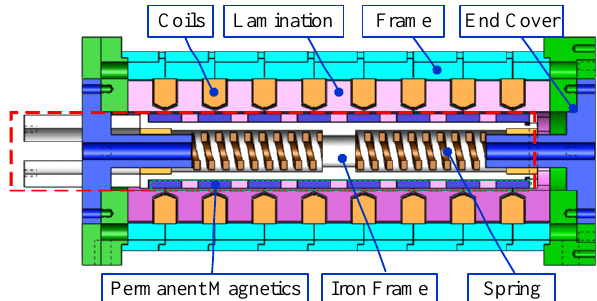
Figure 1. Cross section of PMLOSM.